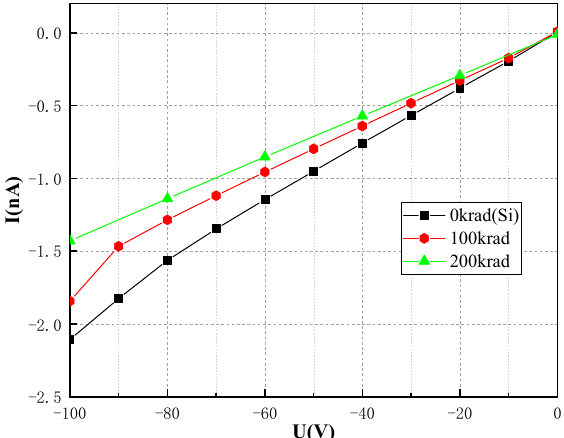
Figure 3. Typical dark I–V reverse characteristic curve of the CsPbBr 3 detector.